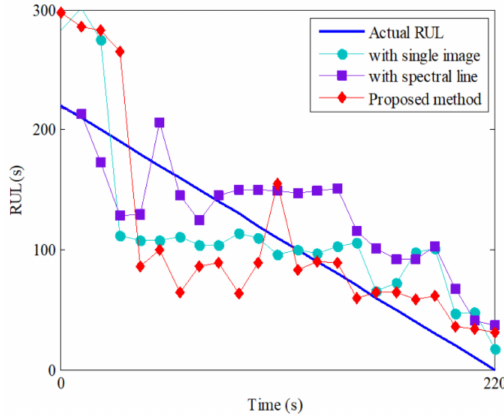
Figure 7. RUL prediction results of bearing